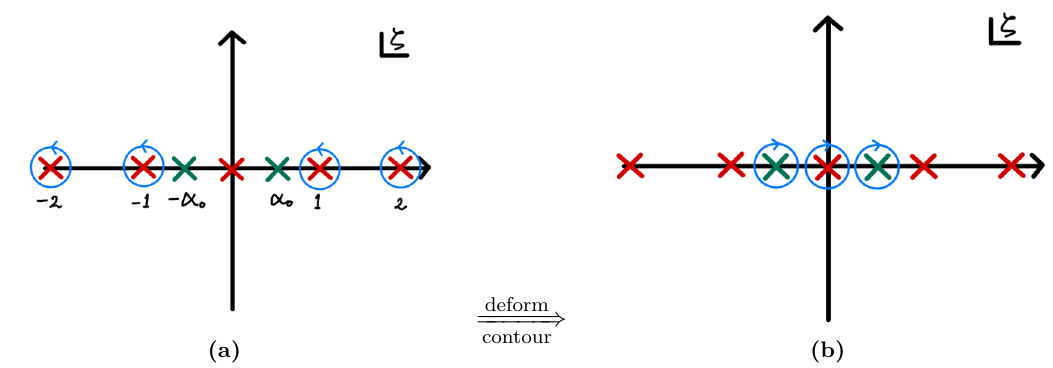
Figure 3 . The soft mode contribution can be written as a contour integral along a collection of small counterclockwise circles centered at ζ ∈ Z / { 0 } . By deforming the contour, it can be expressed as the residue at ζ = 0 and ± α 0 ≡ ±